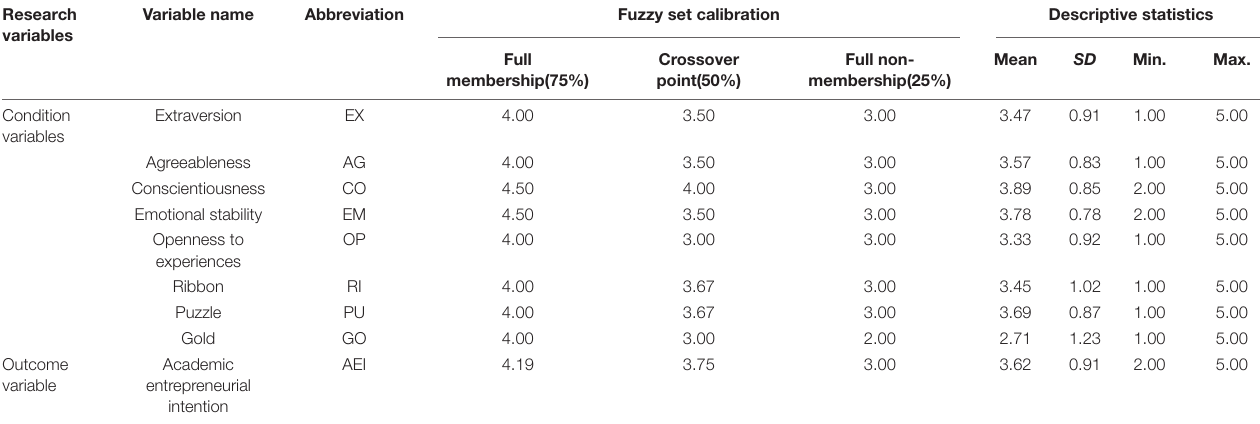
TABLE 2 | Calibration anchor points and descriptive statistics of condition variables and outcome variables. Research